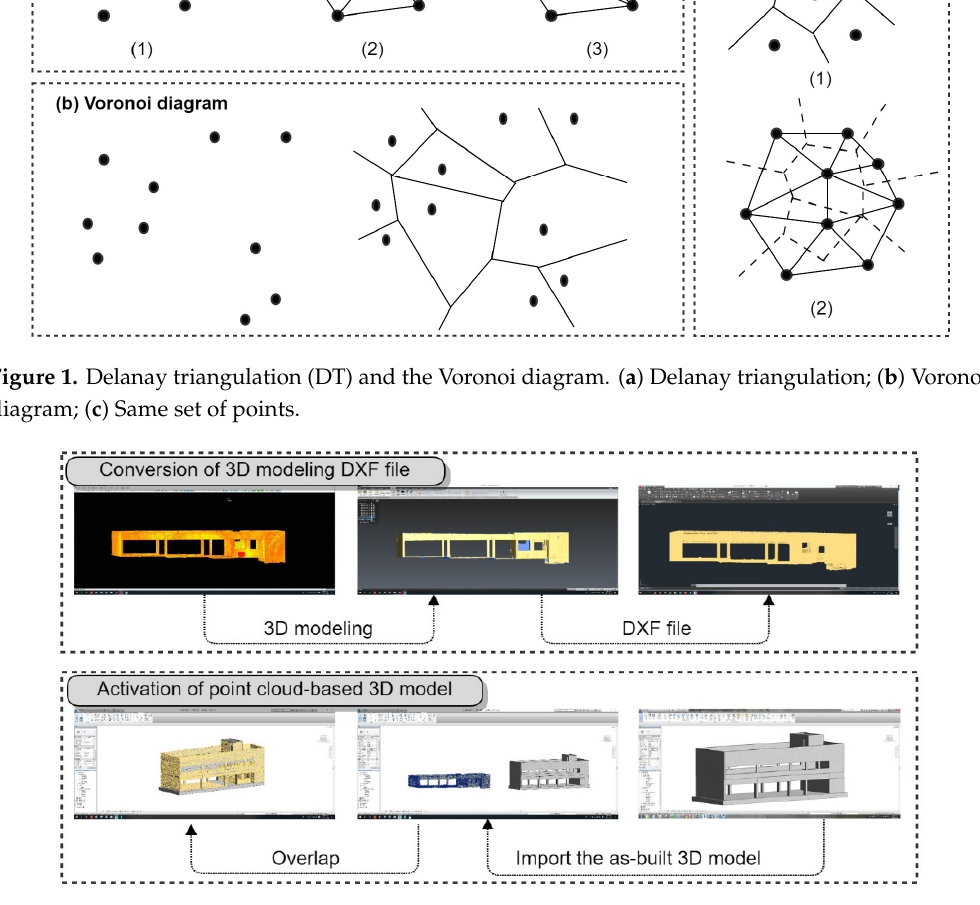
Figure 1. Delanay triangulation (DT) and the Voronoi diagram. ( a ) Delanay triangulation; ( b ) Voronoi diagram; ( c ) Same set of points.